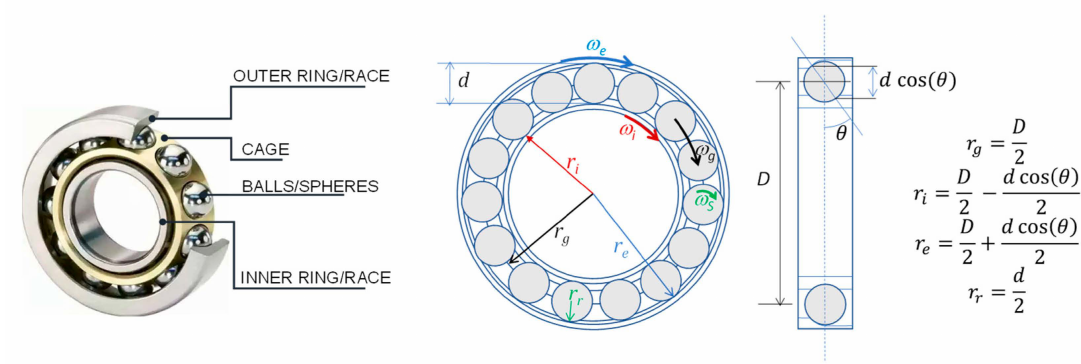
Figure 1. The basic elements of a rolling bearing and the related geometric